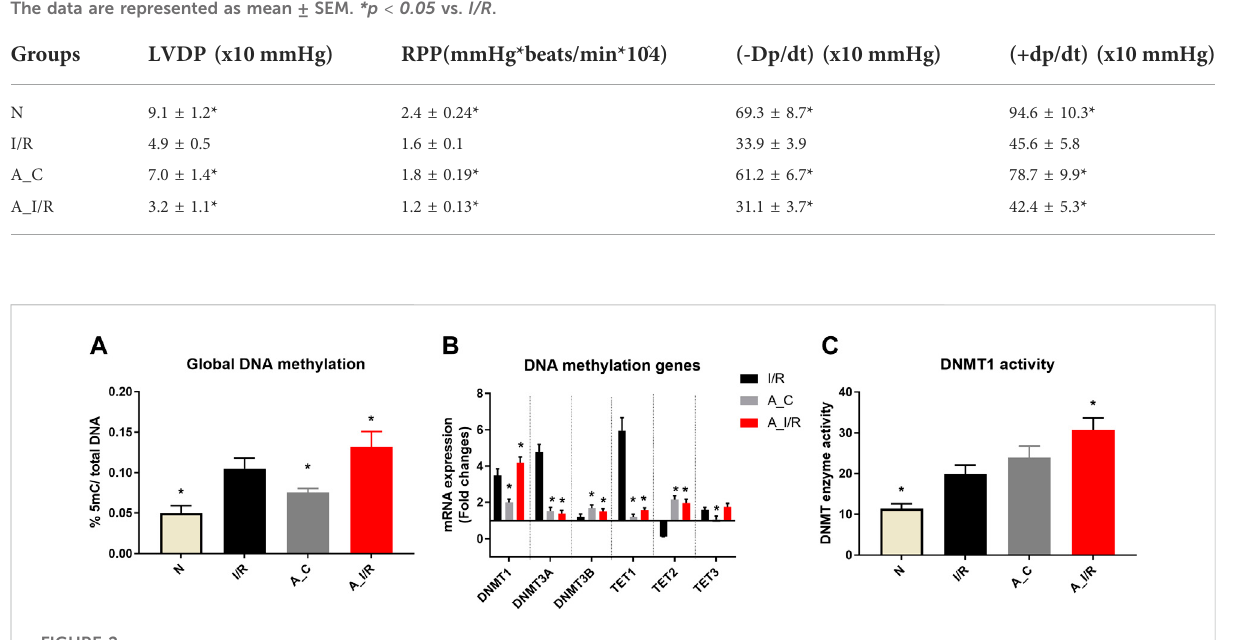
FIGURE 2 Methylation changes in I/R challenged young and adult rat hearts: The global level changes in methylation were assessed from (A) global DNA methylation level; (B) The gene expression of DNA methylation enzymes (expressed as fold changes from normal); and (C) DNMT enzyme activity. The graphs represent mean ± SD values. *p < 0.05 vs. I/R